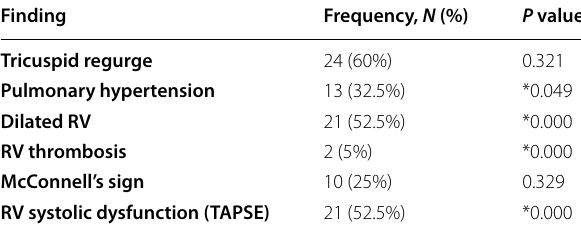
*Significant P value < 0.05